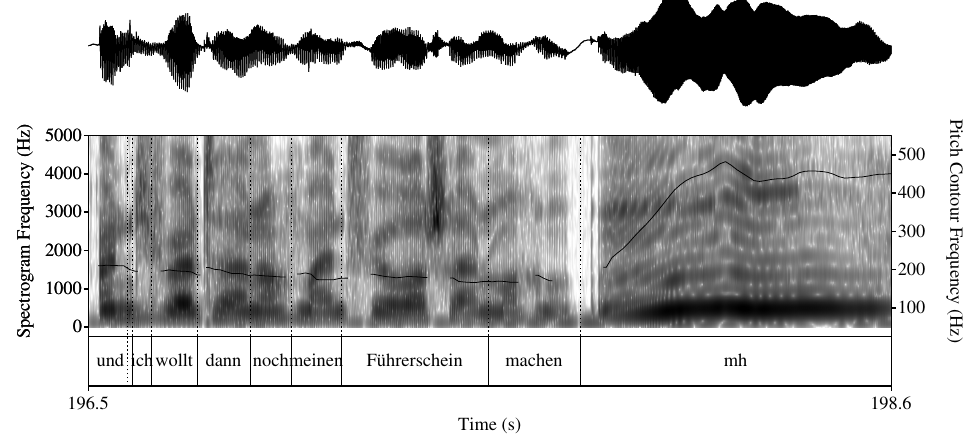
Figure 10. Example of mh (687ms) used as an interjection in und ich wollt dann noch meinen Führerschein machen mh ‘and then I wanted to get my driver’s license mh’ (source